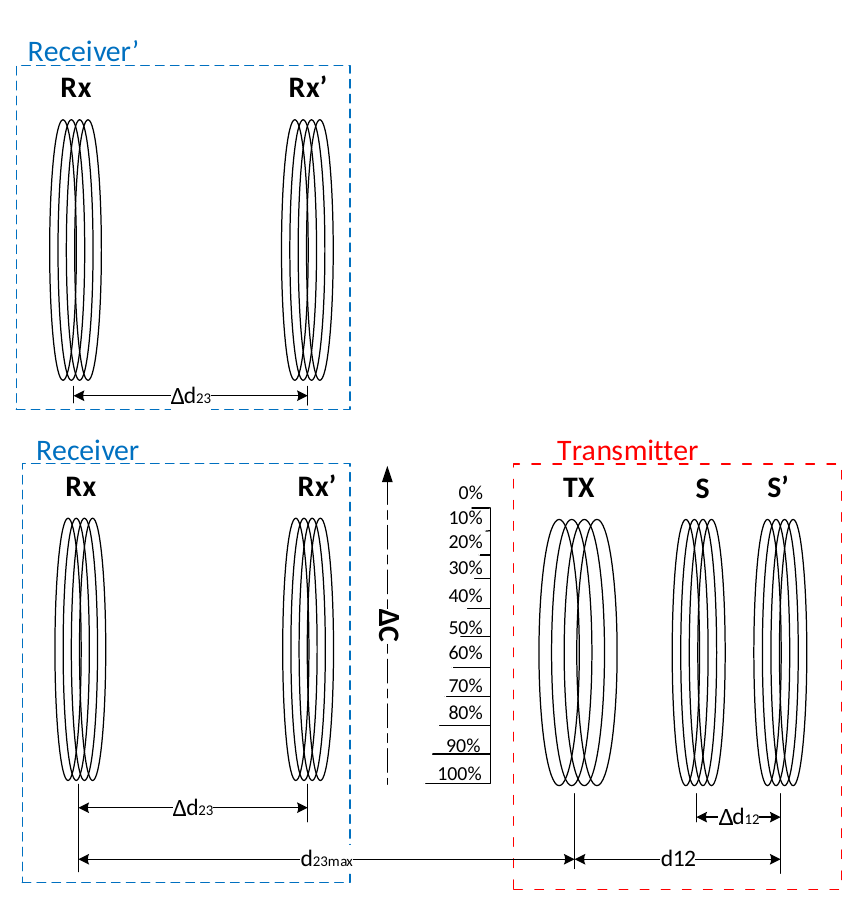
Figure 15. Positioning of the receiver for the measurement of the misalignment